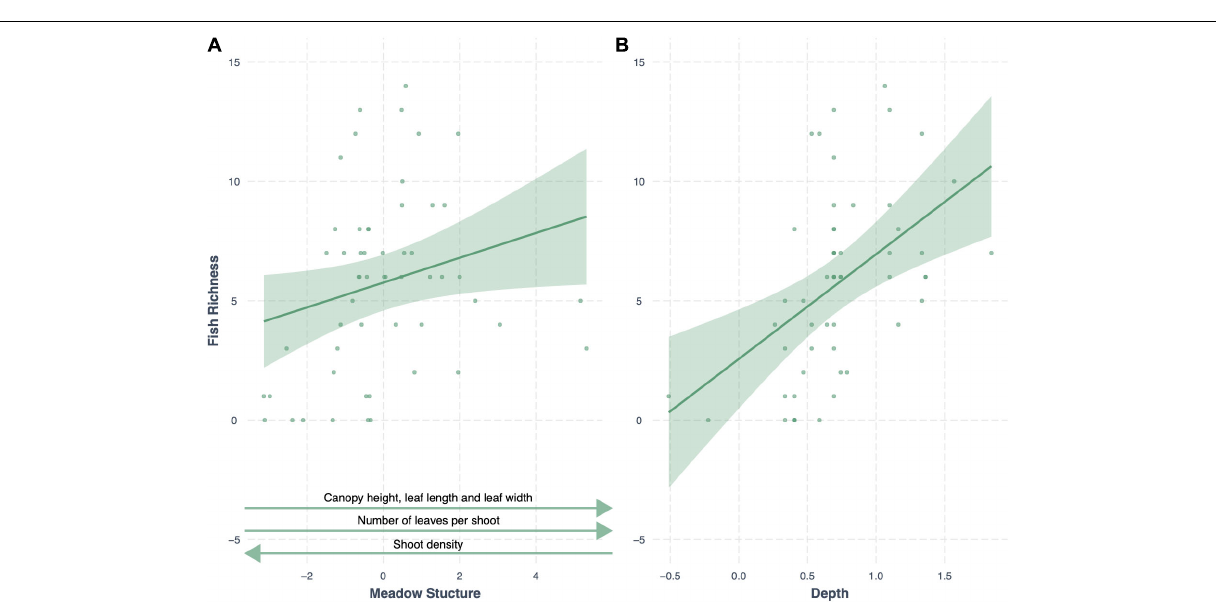
AIC score > 2, and only meadow structure variability was a better predictor than the null model ( Table 3